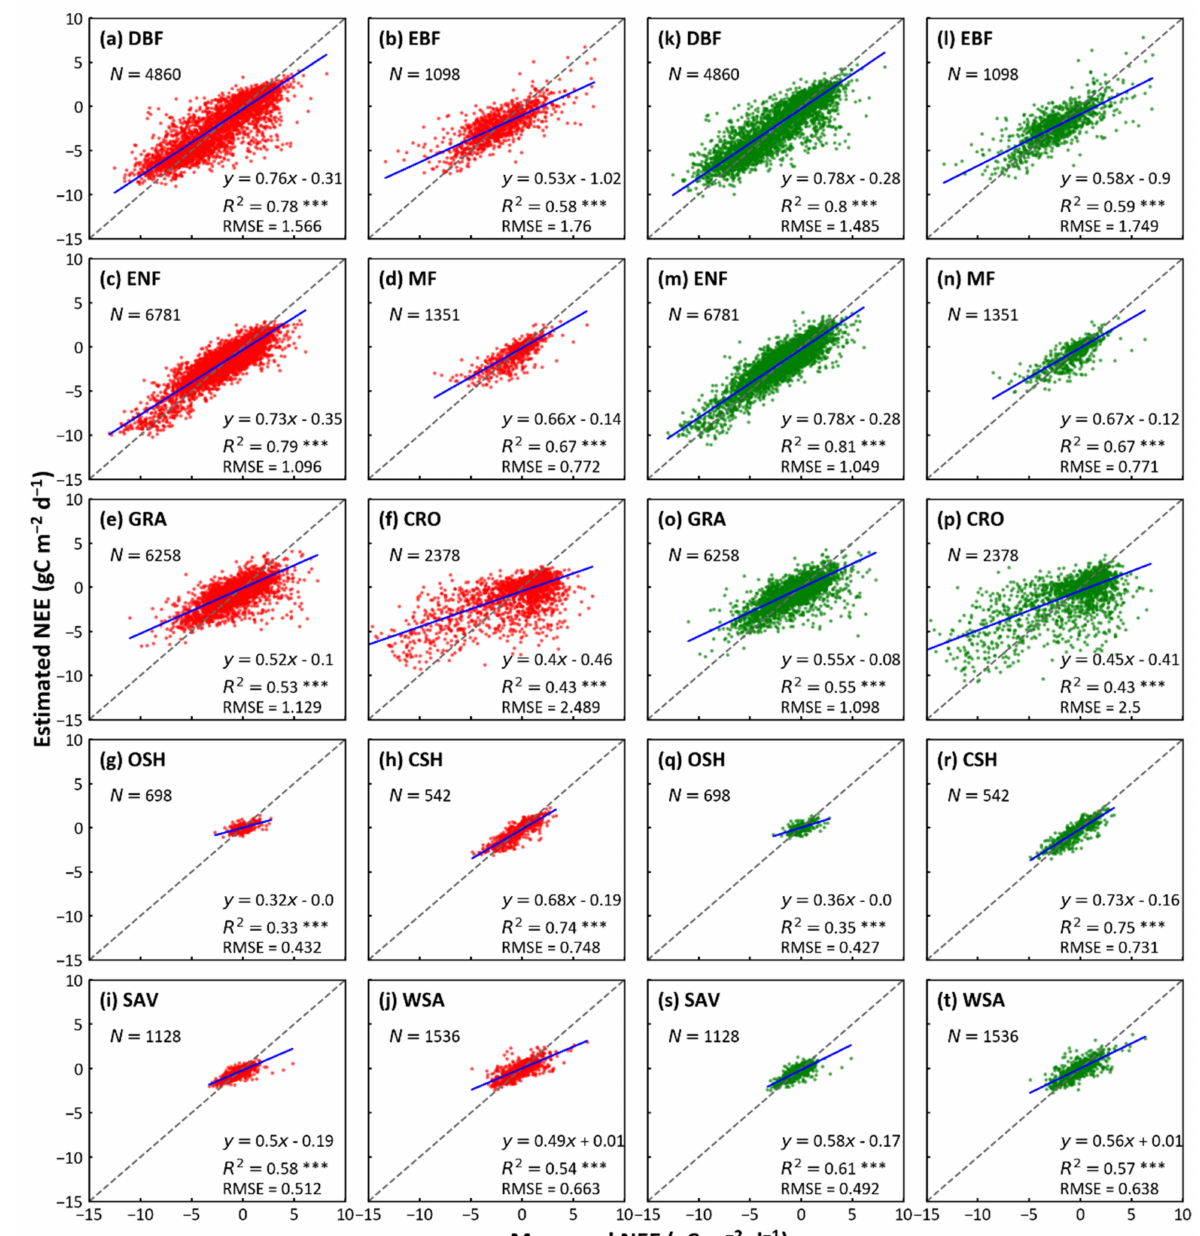
Figure 2. Comparison of predicted and actual values using RF and XGBoost models in each biome. The x-axis represents actual values of NEE by eddy-covariance and y-axis denotes the predicted values by the two models above. The red and green scatters indicate the prediction of RF and XGBoost for each biome, respectively. The dash line represents the equality of predicted and actual values. R 2 refers to the determination, RMSE refers to root mean square error, N refers to the number of test data points. * p -value ≤ 0.05, ** p -value ≤ 0.01, and *** p -value ≤ 0.001. (DBF, deciduous broadleaf forest; EBF, evergreen broadleaf forest; ENF, was evergreen needleleaf forest; MF, mixed forest; GRA, grassland; CRO, cropland; OSH, open shrublands; CSH, closed shrublands; SAV, savannas; WSA, woody